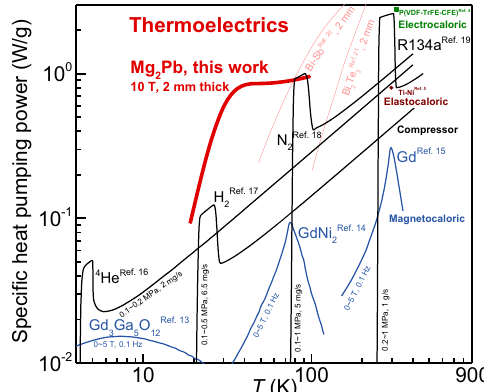
Fig. 1 Temperature ( T ) dependent speci fi c heat pumping power ( q ) for a variety of heat pumping techniques. The speci fi c heat pumping power is estimated by the thermodynamic parameters of materials and the typical working conditions 4,5,37 – 45 (labeled beside the solid lines). For thermoelectrics, q = T 2 S 2 σ /2/( h / A ), where h and A represent the thickness along the direction of heat fl ow and the cross-sectional area of the materials. More details are given in Supplementary Table 1.